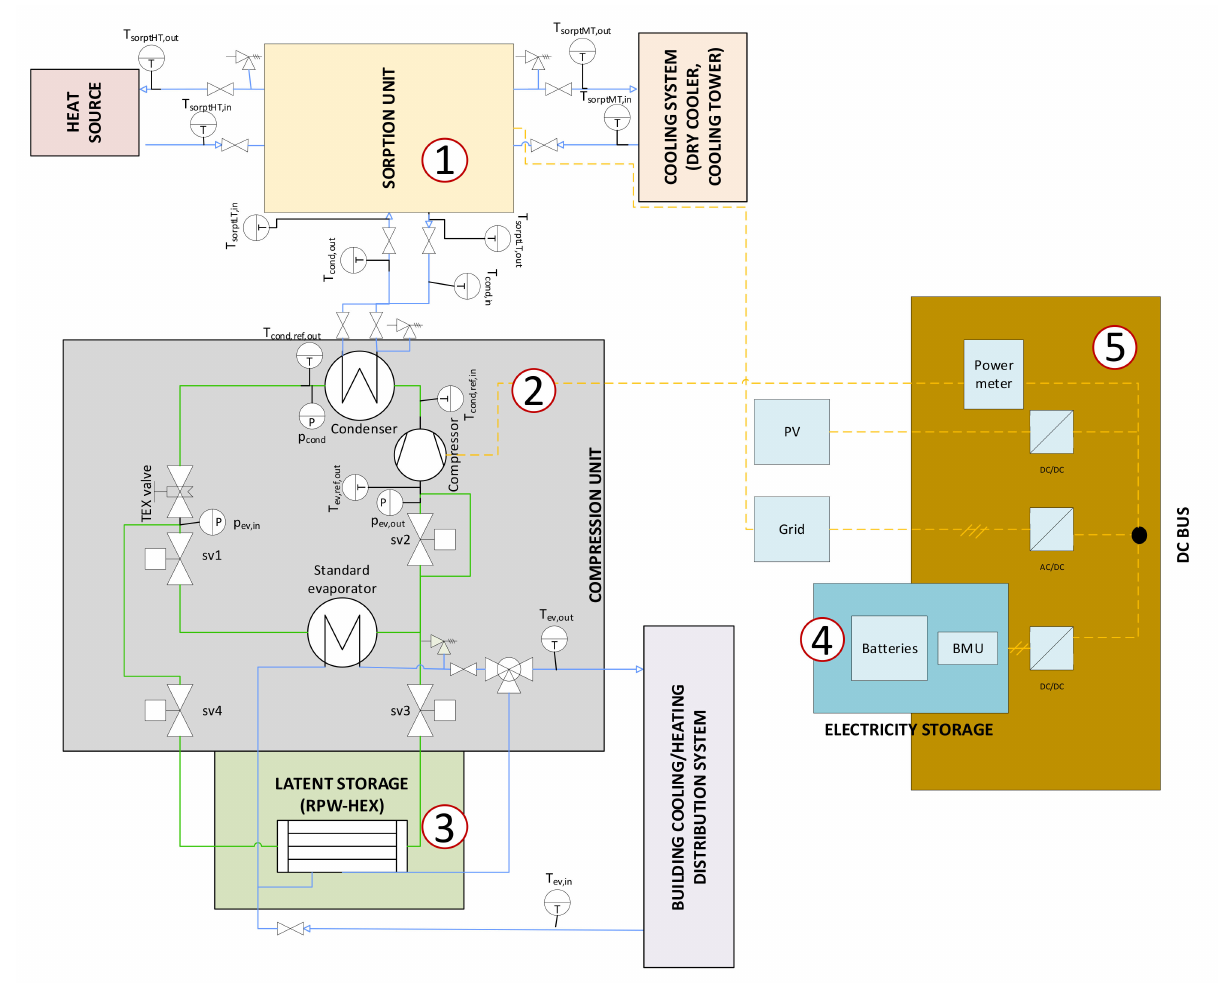
Figure 1. Layout of the hybrid system, including the main sensors used and their names. A picture of the installed system connected to the test stand at CNR ITAE is shown